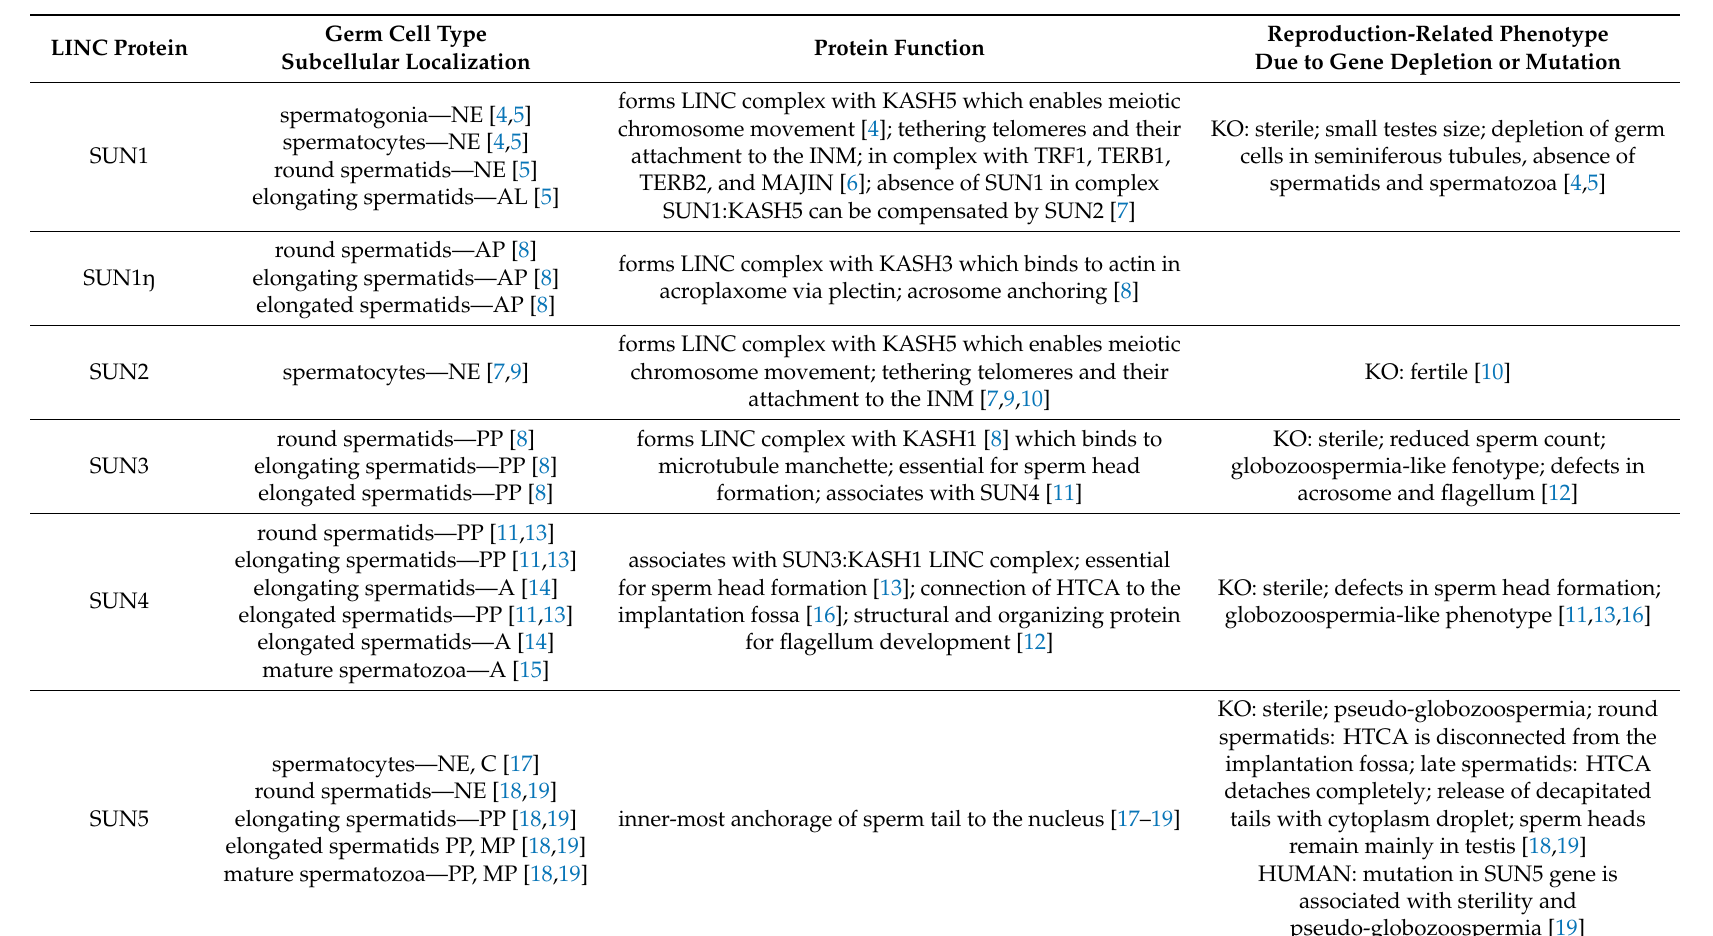
Table 1. Overview on localization and function of LINC complex proteins present in adult male germ